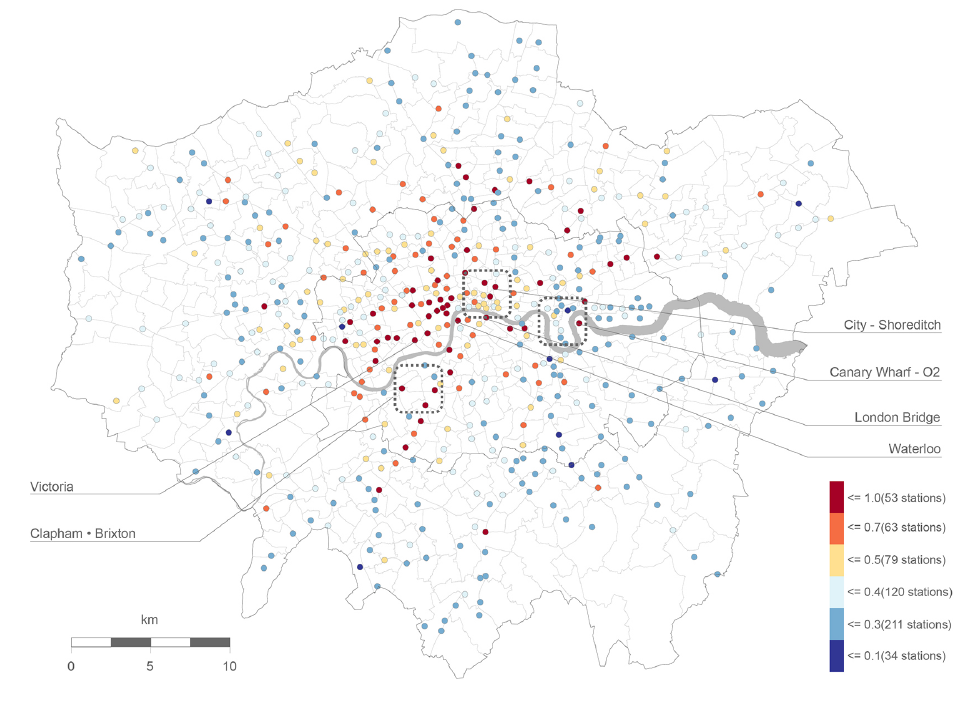
Figure 7: Vitality values for an average weekend